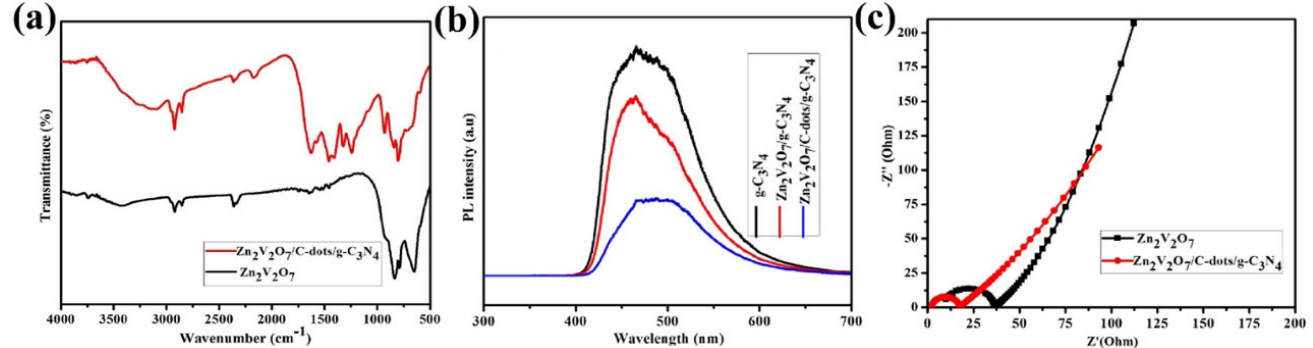
Figure 5. ( a ) Fourier transform infrared spectrum, ( b ) time-resolved photoluminescence analysis, and ( c ) electron impedance spectroscopy of Zn 2 V 2 O 7 /CQDs/g-C 3 N 4 hybrid and Zn 2 V 2 O 7 . Reproduced with permission from Ref. [65] Copyright Springer 2019.